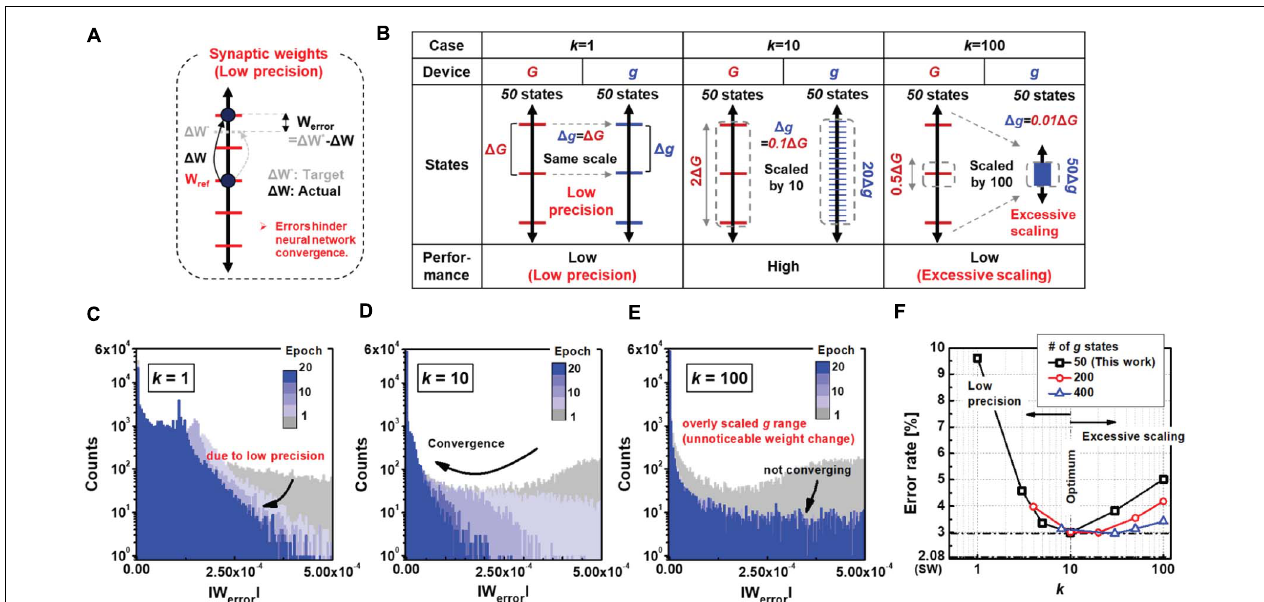
FIGURE 5 | (A) Weight states of a single synapse with electronic devices that have finite number of conductance states. During the weight update process, errors may occur due to the low precision. W error denotes the difference between the target and actual weights. (B) Comparison with other cases for k values of 1, 10, and 100; a moderate k value of 10 is suitable for low errors in weight updates. (C–E) Histograms of mean weight errors for different k values. When k is 1 (C) , the weight resolution does not increase causing low error convergence. When k is 100 (E) , the weights of small synapses are excessively scaled. Thereby, the overly scaled conductance leads to unnoticeable weight changes with saturated error convergence. (F) Classification of error rate as a function of k value. At least 10 must be secured to achieve high accuracy with high-precision synaptic weights. Note that saturated error convergence due to a high value of k can be improved with a larger number of g states in the device for the small